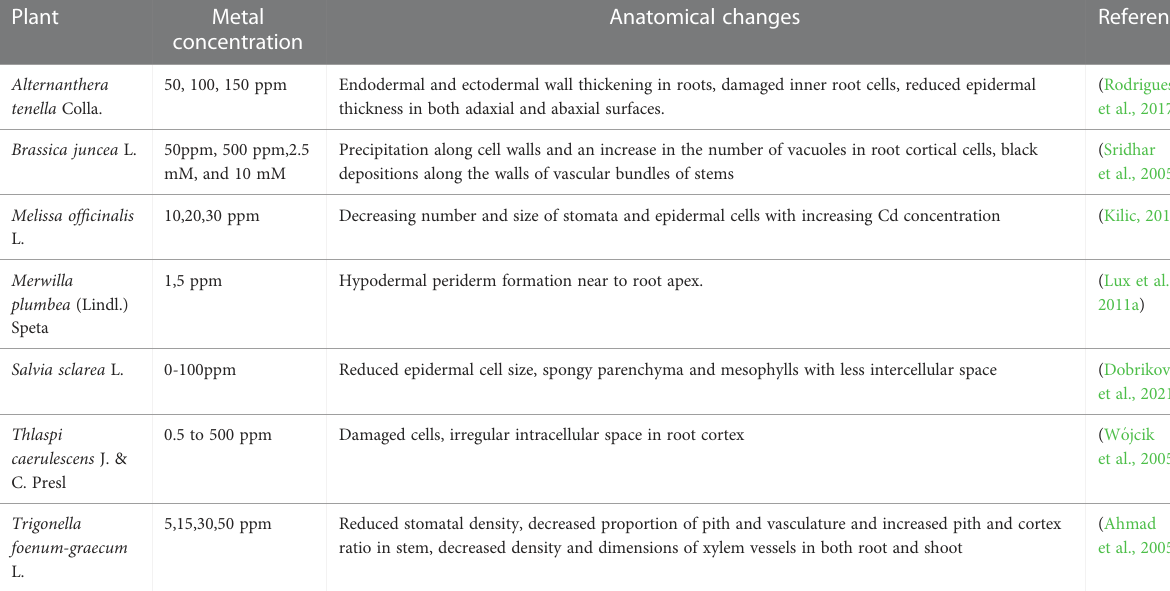
TABLE 2 Anatomical changes in cadmium treated medicinal plants. Plant Metal